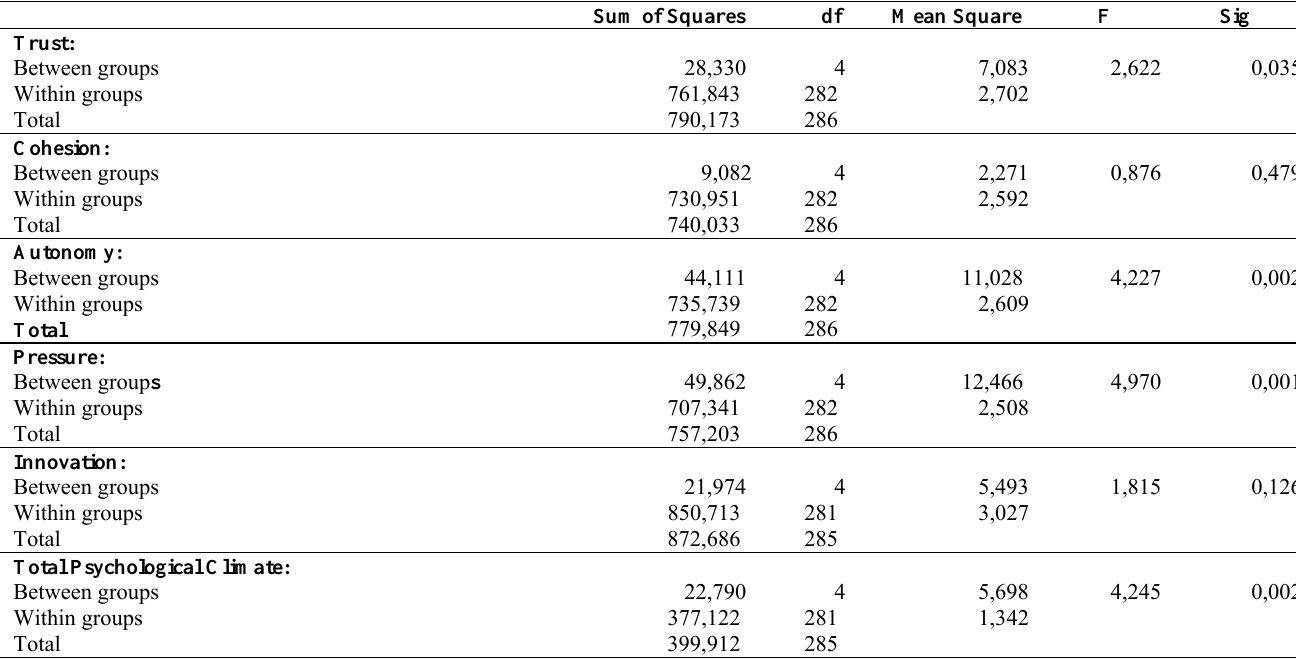
Table 3: Difference between departments (Oneway Anova)